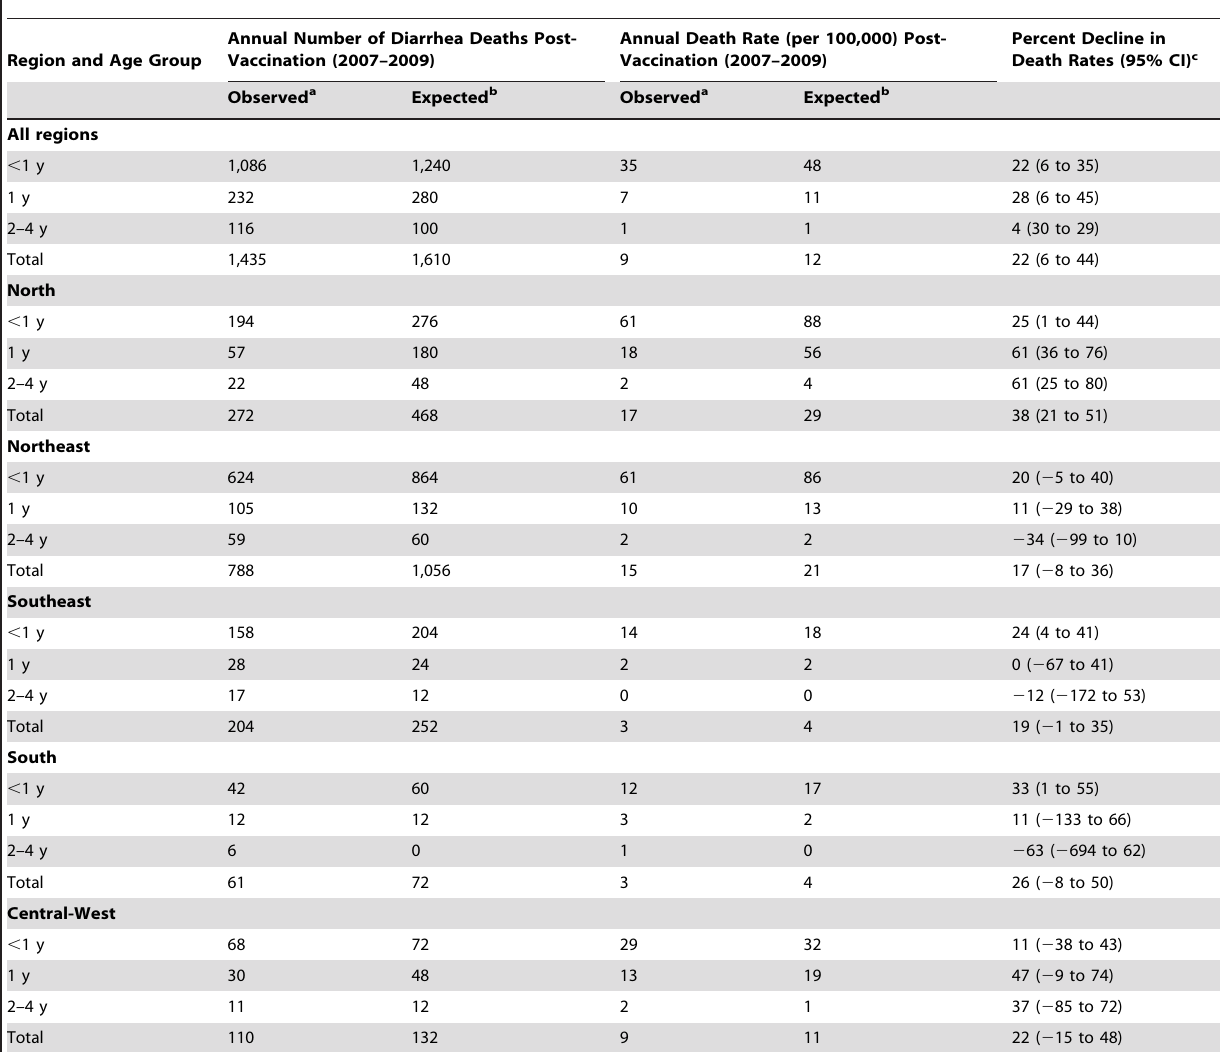
Table 2. Post-vaccination changes in numbers of diarrhea-related deaths and mortality rates among children younger than 5 y by December 2009 in